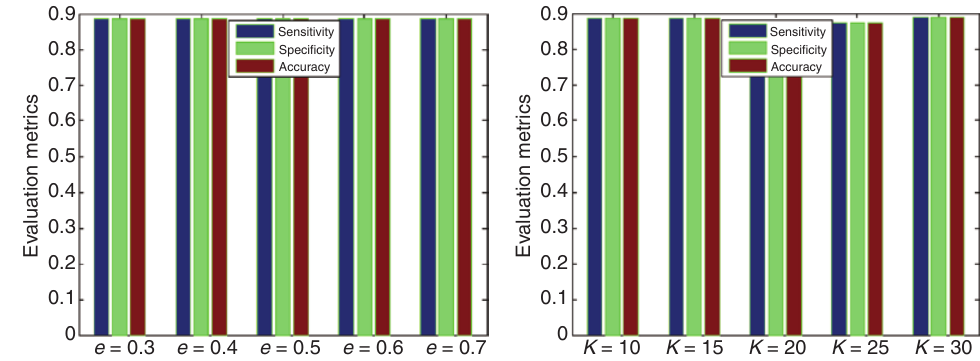
Figure 8: DRD for Various e and K Values.